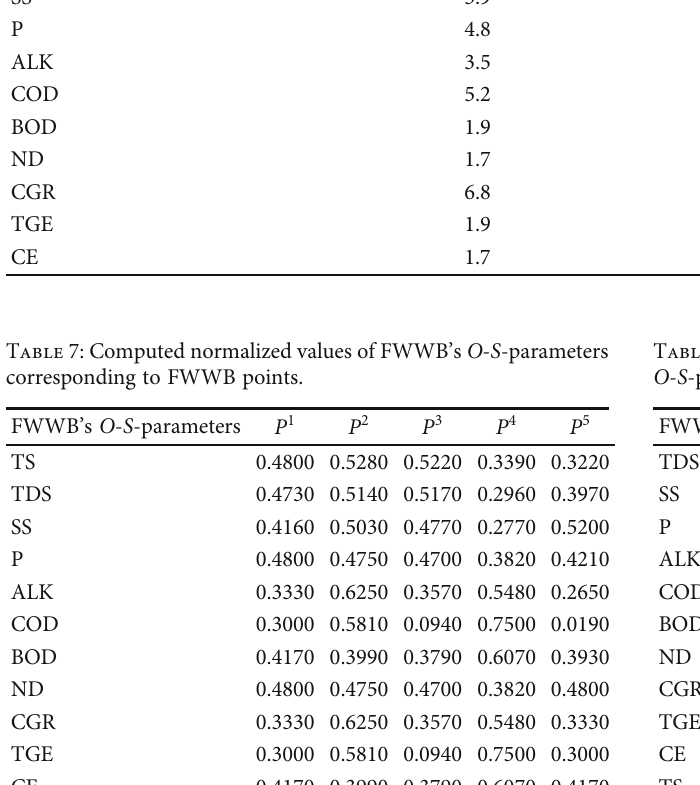
linking FWWB ’ s O - S -parameters i